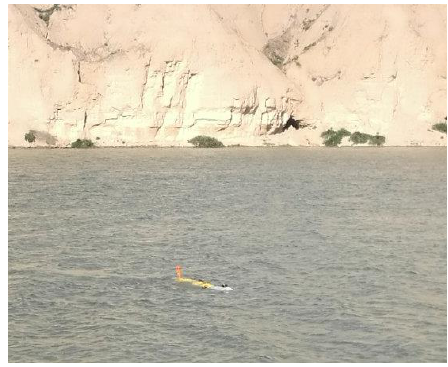
Figure 11. Area search test.